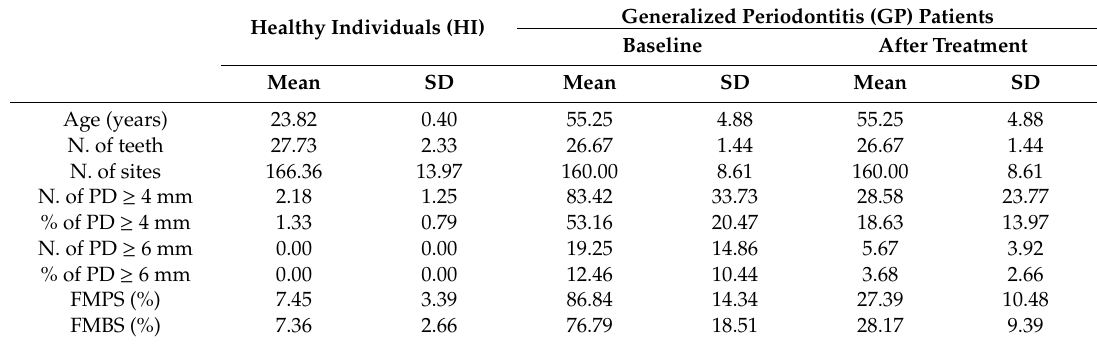
Table 1. Demographic and clinical parameters in healthy and periodontitis patients before and after non-surgical periodontal